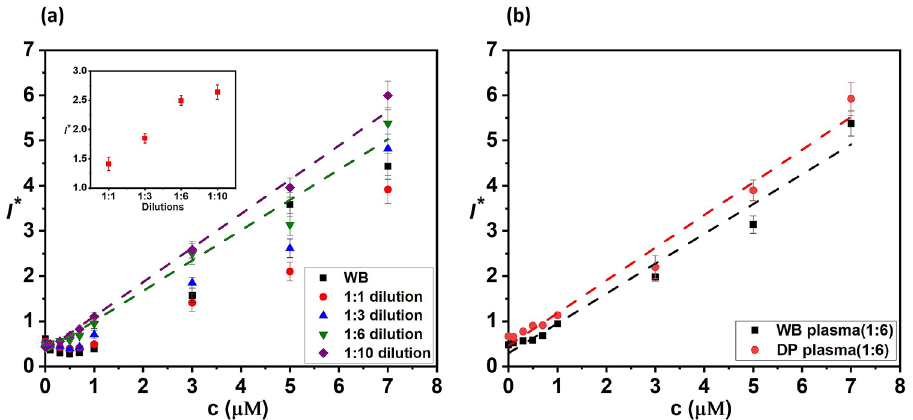
Figure 4. ( a ) Variation of FL intensity with H 2 O 2 concentration in buffer-diluted whole human plasma at different dilutions, inset shows the variation of FL intensity with dilution for c = 3 (linear fits with R for both 1:6 and 1:10 dilutions). ( b ) Variation of FL intensity with H 2 O 2 concentration in buffer-diluted